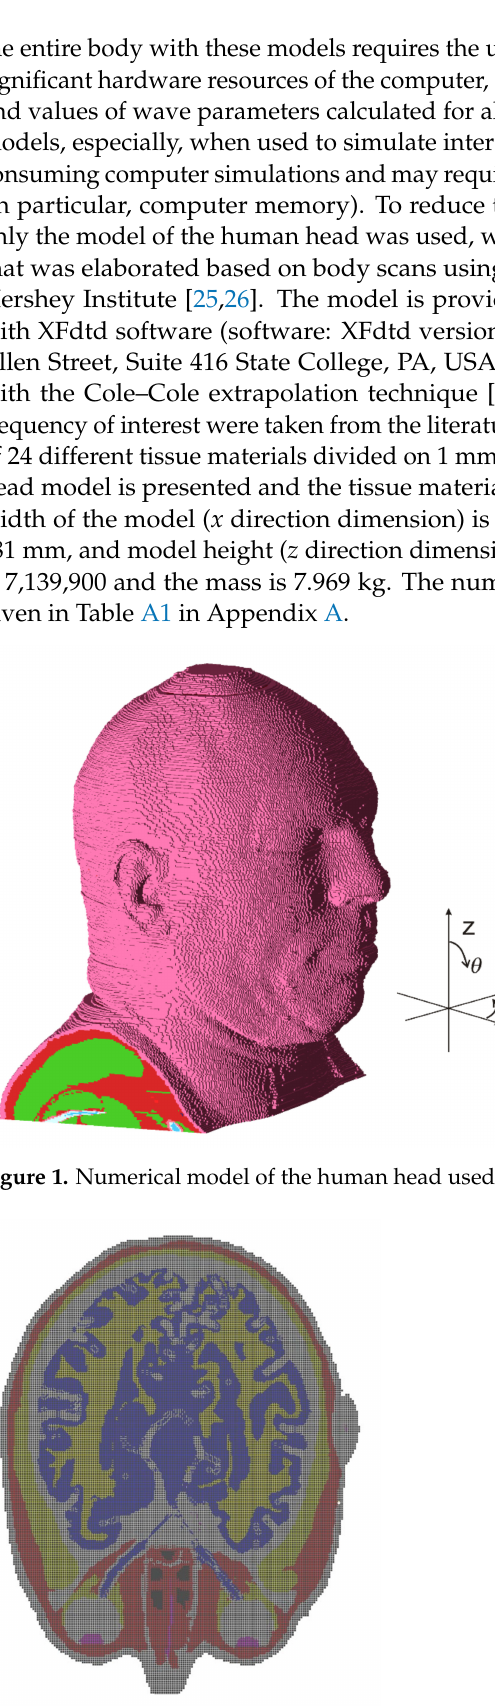
Figure 2. Numerical model cross-section of the